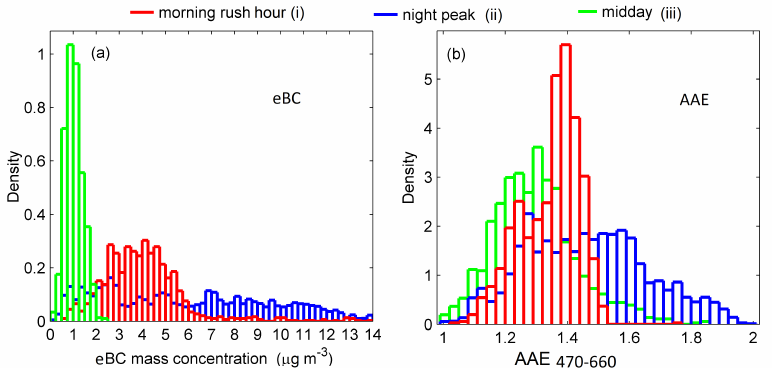
Figure 13. Probability density functions (pdf) of ( a ) eBC mass concentration (MAAP) and ( b ) Absorption Ångström Exponent from 470 to 660 (AE33) during ( i ) the week-day morning rush hour; ( ii ) the week-day night peak; and ( iii ) the weekend midday. Only data measured during no dusty working days are